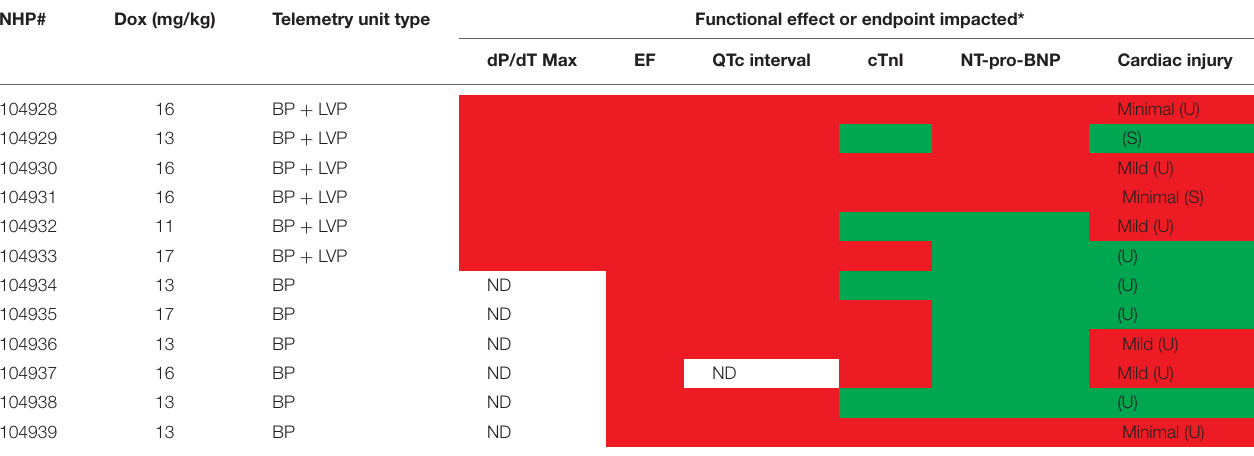
TABLE 4A | Relationship between contractile function, cardiac biomarkers, QTc interval and myocyte injury in NHP treated chronically with doxorubicin. NHP# Dox (mg/kg) Telemetry unit type Functional effect or endpoint impacted* dP/dT Max EF QTc interval cTnI NT-pro-BNP Cardiac injury 104928 Minimal (U)